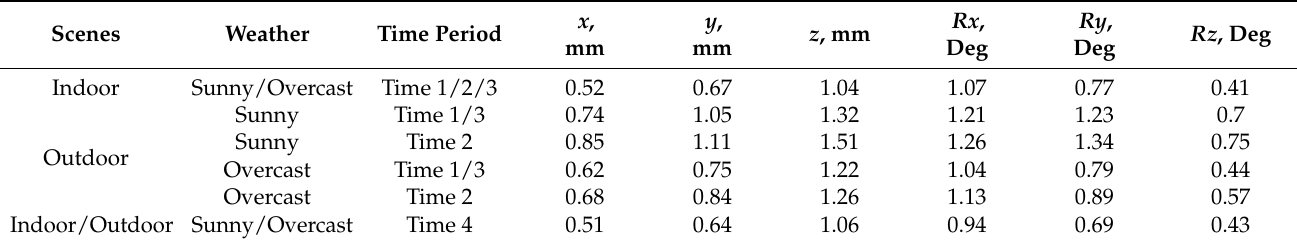
Table 4. Pose errors in the aiming